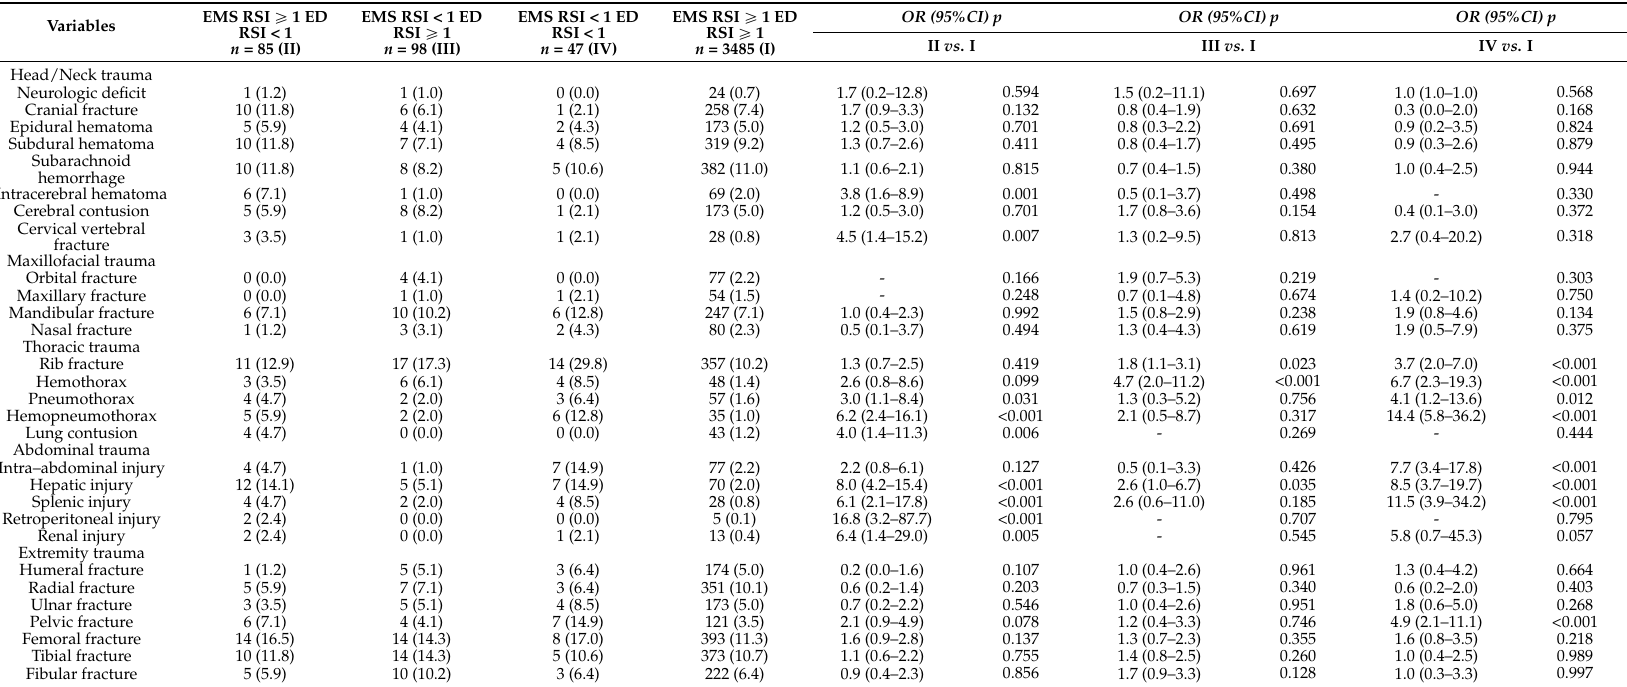
Table 3. Associated injuries of hospitalized trauma patients.